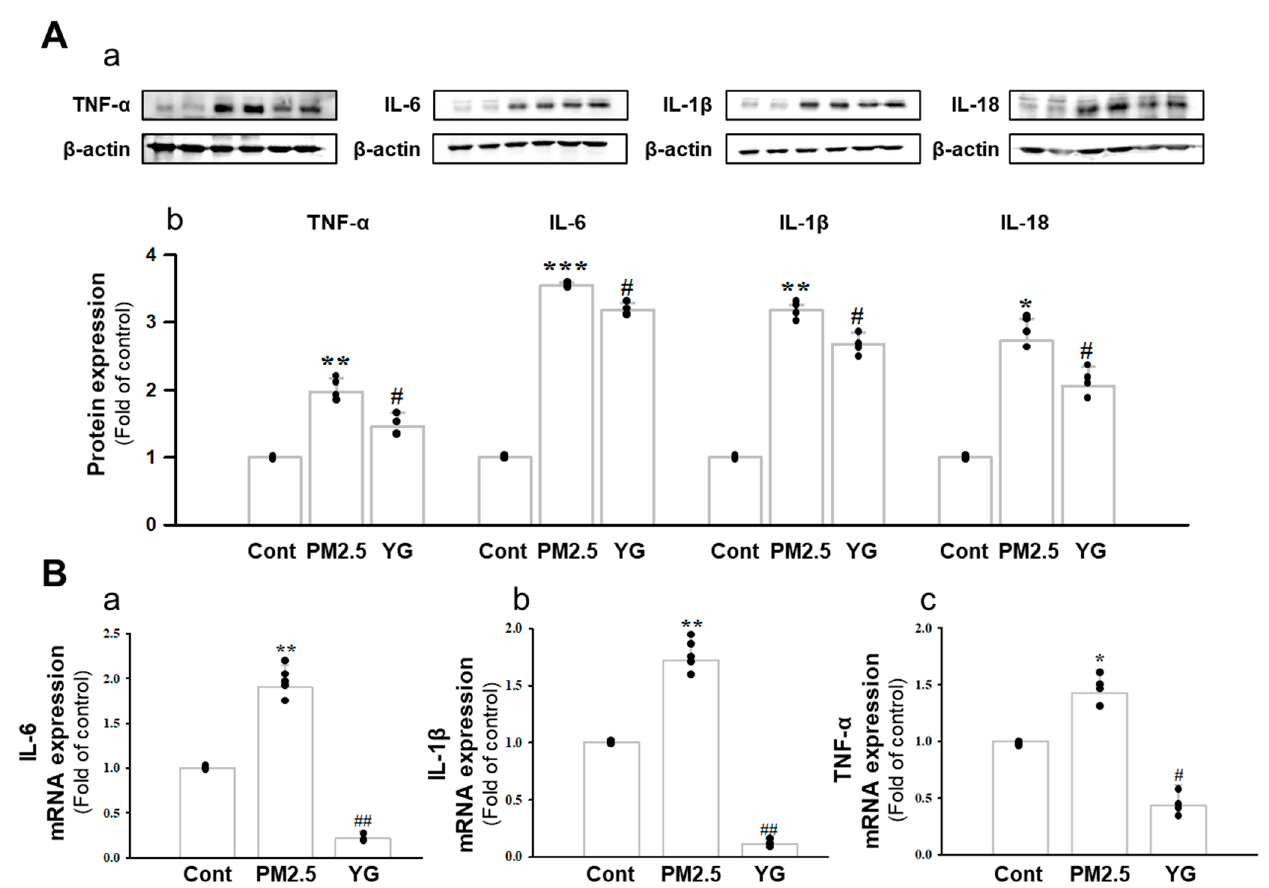
Figure 7. Treatment of YG-1 extract improved acute bronchial and lung injury in fine particulate matter (PM2.5)-stimulated mice. Increased protein expression of TNF- α , IL-6, IL-1 β and IL-18 inflammatory cytokines in PM2.5-stimulated mice was improved by YG treatment ( A ). Bronchial damage in PM2.5-stimulated mice increased IL-6, IL-1 β and TNF- α mRNA levels and was inhibited by YG-1 treatment ( B ). β -actin was used as loading controls for protein and mRNA expressions ( n = 3~5 for each group). Cont, control; PM2.5, PM2.5 exposure mice; YG-1, PM2.5 exposure mice + YG-1 treated (200 mg/kg/daily, orally); TNF- α , tumor necrosis factor alpha; IL-6, interleukin 6; IL-1 β , interleukin 1 beta; IL-18, interleukin 18. Data are expressed as mean ± standard error. * p < 0.05, ** p < 0.01, and *** p < 0.001 vs. control; # p < 0.05, ## p < 0.01 vs. PM2.5.